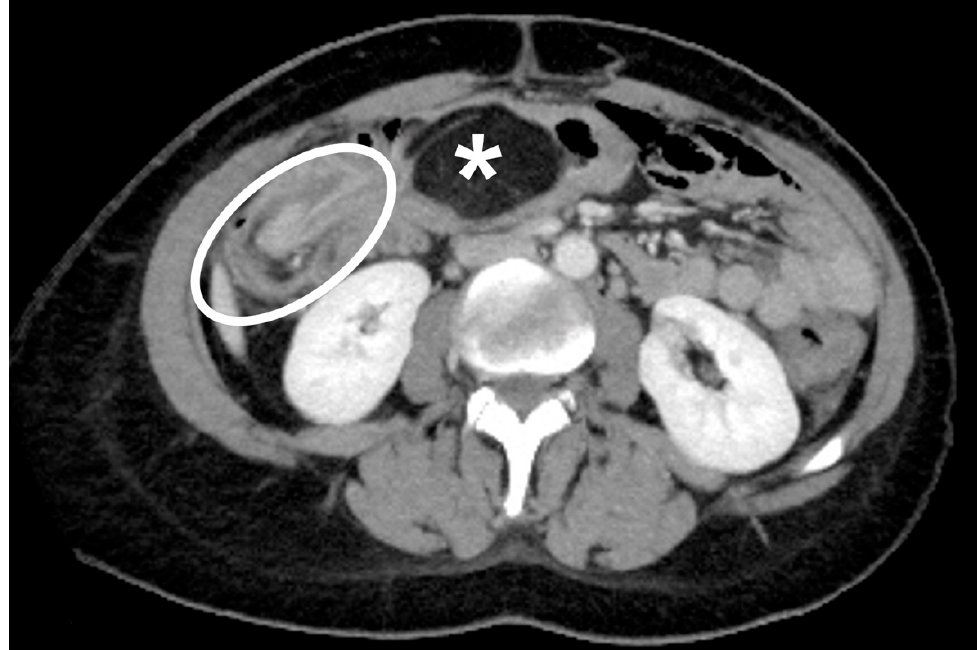
Figure 2. Axial CT scan of the abdomen in portal/venous phase. A rounded, smoothly outlined and sharply demarcated abdominal mass, having fat attenuation mass with fat attenuation (aster- isk) is observed. A circumferential thickening in ileocolic intussusception caused by the lipoma can be seen (white circle).